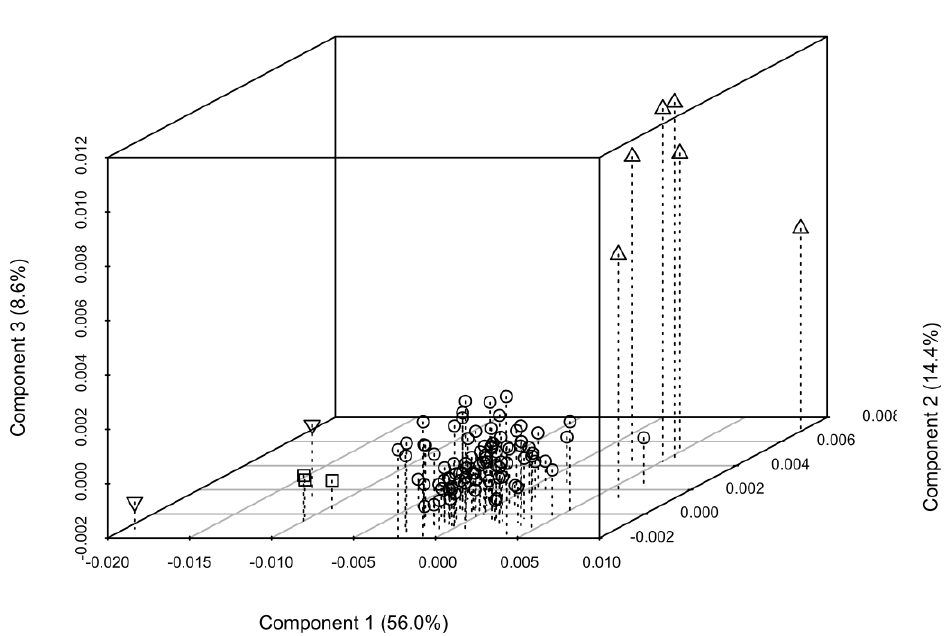
Figure 7. Three-dimensional (3D) Score plot generated by PCA of part of the anomeric signals region. Sample clusters corresponding to the different families of crude heparin are defined. BMHC (above pointing triangles), OMHC (squares) and BLHC (below pointing triangles), against the library of PMHC (circles).